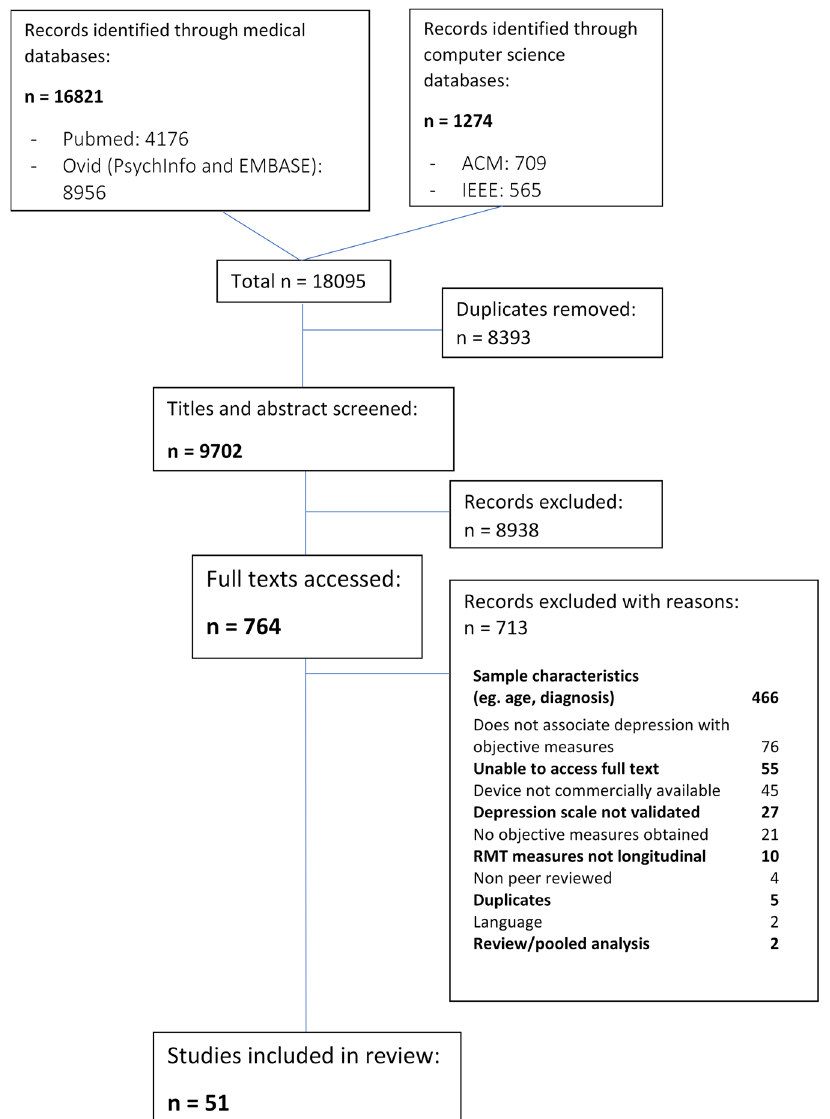
Fig. 1 Study selection fl owchart. Medical and computer science databases were searched to ensure relevant fi elds were covered. The current fl owchart lists reasons for excluding the study from the data extraction and quality